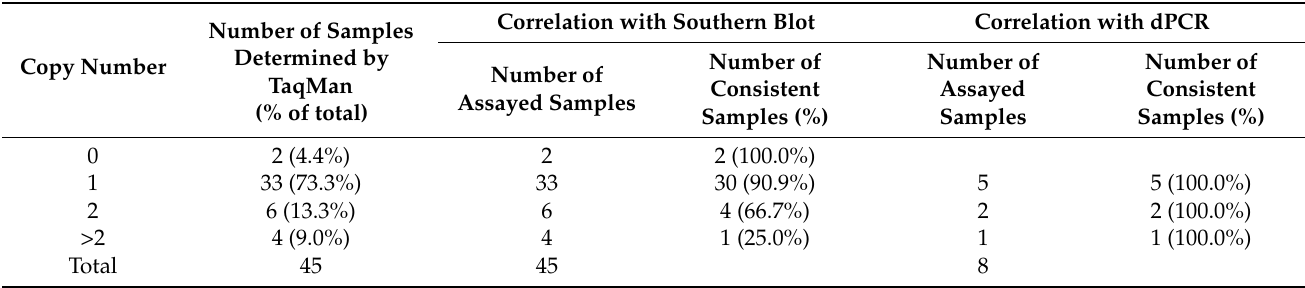
Table 3. Correlation of TaqMan with Southern blot and dPCR assay for transgene copy determination.